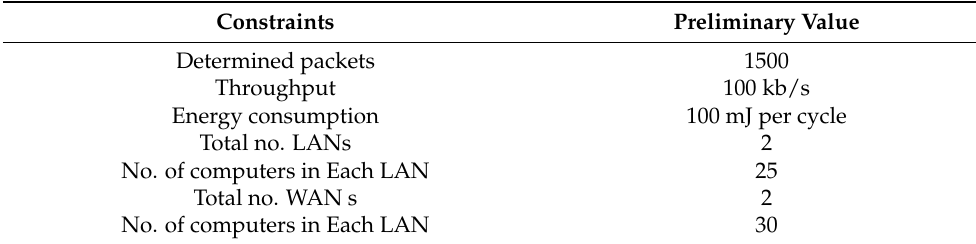
Table 1. Initial Network parameters